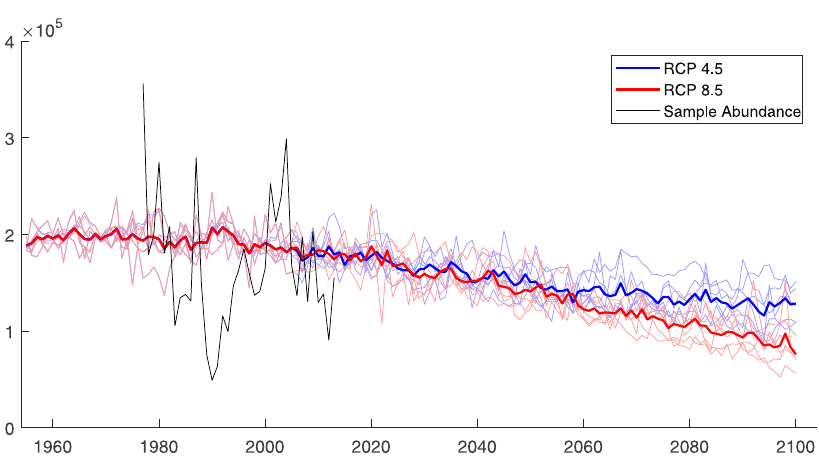
Figure 3. Projected density of C . finmarchicus on the Northeast U.S. Shelf. Individual climate model runs are indicated by thin colored lines while the ensemble average is